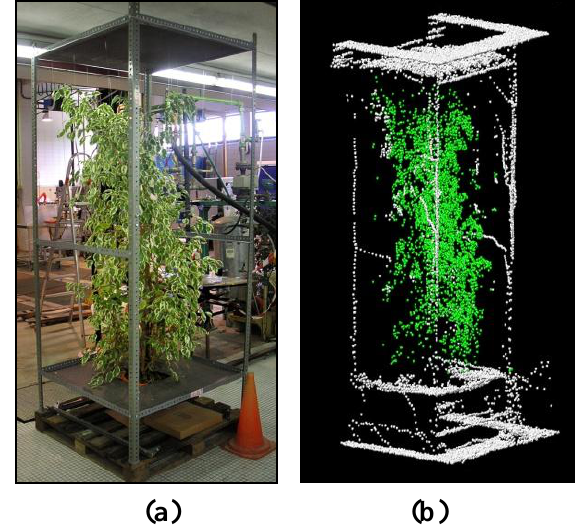
Figure 5. (a) Photograph of the Ficus benjamina inside the reference structure. (b) Graphic representation of the point cloud obtained with the LIDAR